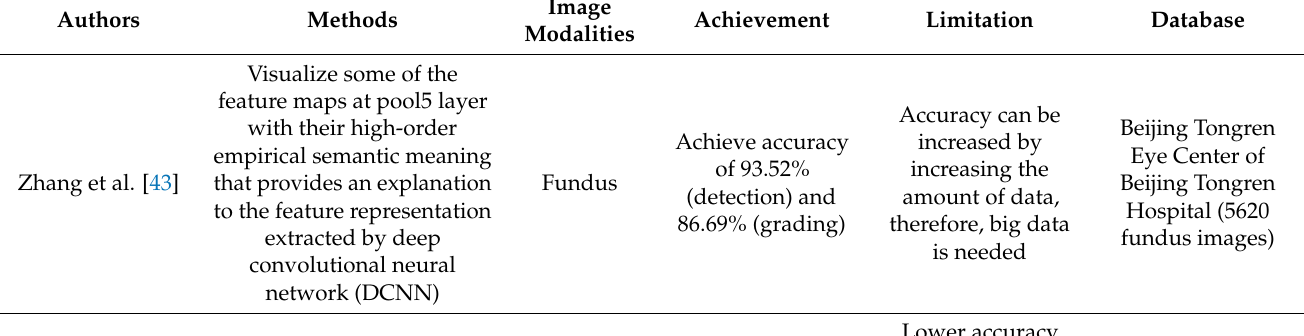
Table 2. Summary of Cataract Detection Using Deep Learning